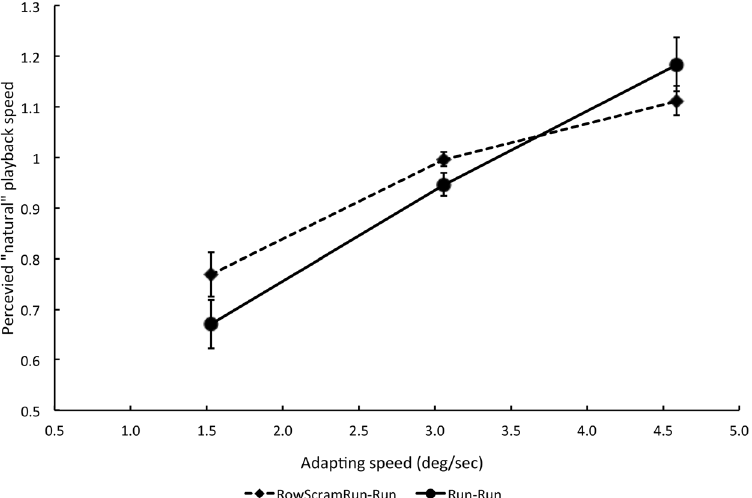
Figure 3. Results of Experiments 4 in comparison with Experiment 2, showing changes in apparently natural running speed using two different adapting patterns. Filled circles Data from Experiment 2 using running adapt and test videos. Filled diamonds Data from Experiment 4 using row-scrambled running adapt and running test videos. Figure convention as in Fig. 1. Each data point represents the mean P50 of five participants ( + / − 1 SE). An adapting speed of 3.06°/s corresponds to standard speed playback of